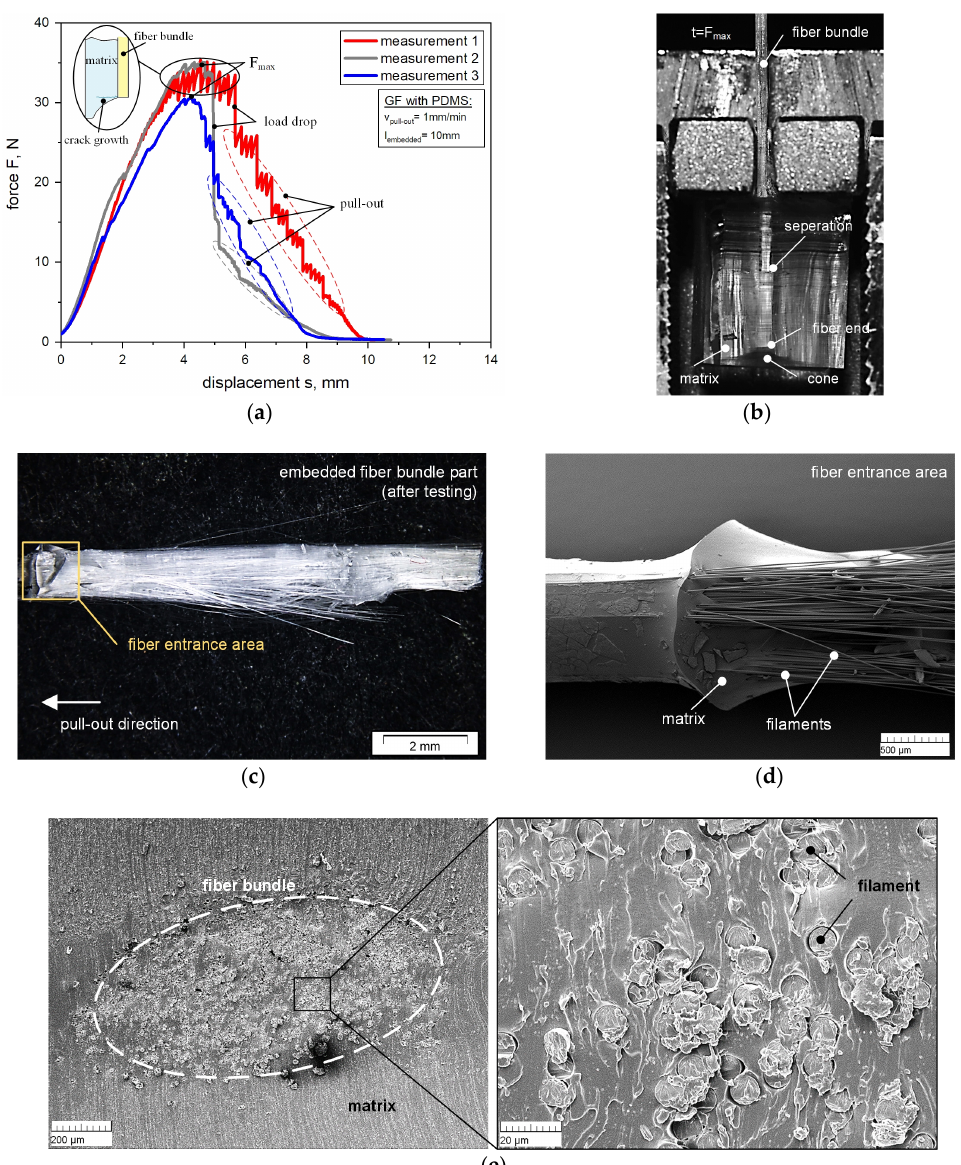
Figure 3. Force-displacement curves obtained from FBPO test on GF with PDMS matrix ( a ) with the separation process ( b ) during pull-out and microscopic images of a FBPO specimen (GF with PDMS) after the test: part of embedded area of GF- bundle ( c ) and SEM of GF- bundle ( d ) and image of cross-section area of embedded GF bundle ( e ).